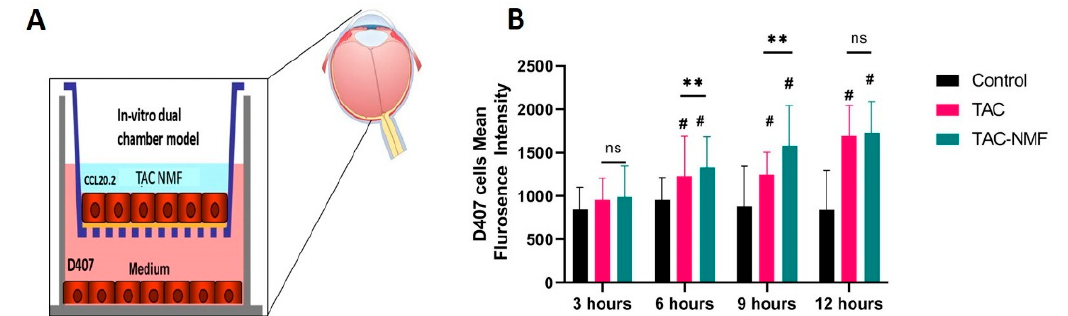
Figure 12. In-Vitro Cellular Transport of TAC-NMF. Schematic representation of the preparation of ( A ) in-vitro conjunctival-retinal dual chamber model and FACS analysis of time dependent in-vitro transport of FITC-labelled TAC-loaded nanomicelles in Transwell diffusion chamber with ( B ) CCL 20.2 and D407 cell lines. Results are expressed as a mean of three independent experiments, n = 3 ± SD. (# ≤ 0.05 as compared to control and ** p ≤ 0.01 between group, ns = not significant difference between groups) .